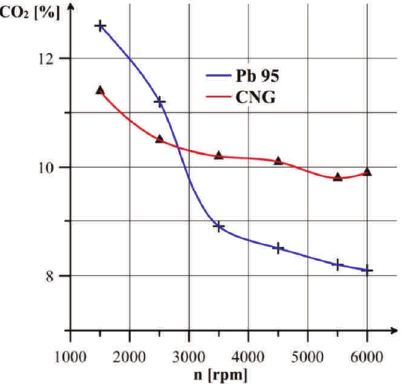
Fig. 8. Concentration of carbon dioxide in the Fiat 0.9 TwinAir engine exhaust gases, working with external speed characteristics and fuelled by petrol Pb 95 and